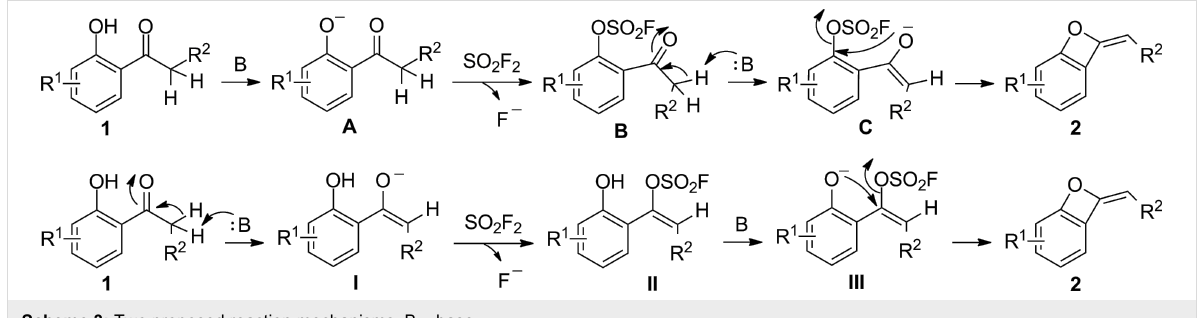
Scheme 3: Two proposed reaction mechanisms. B =